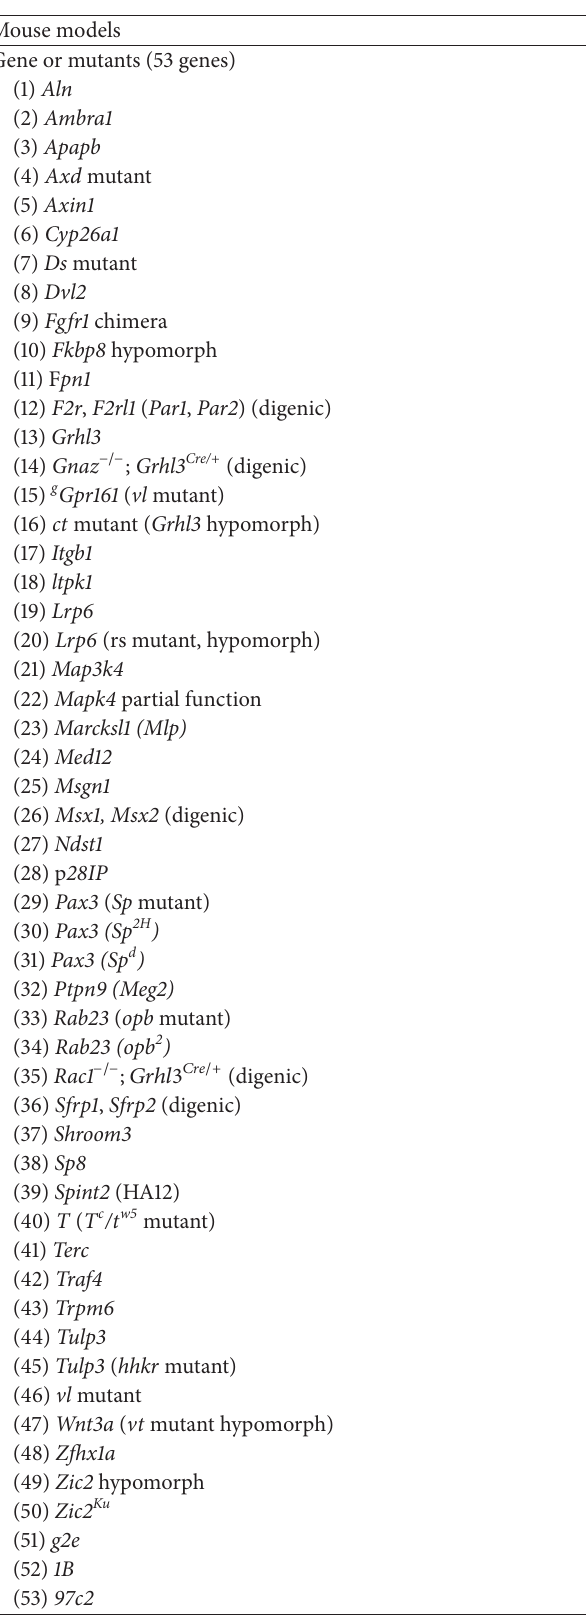
Table 2: List of mouse models that exhibits spina bifida (reviewed in [4,